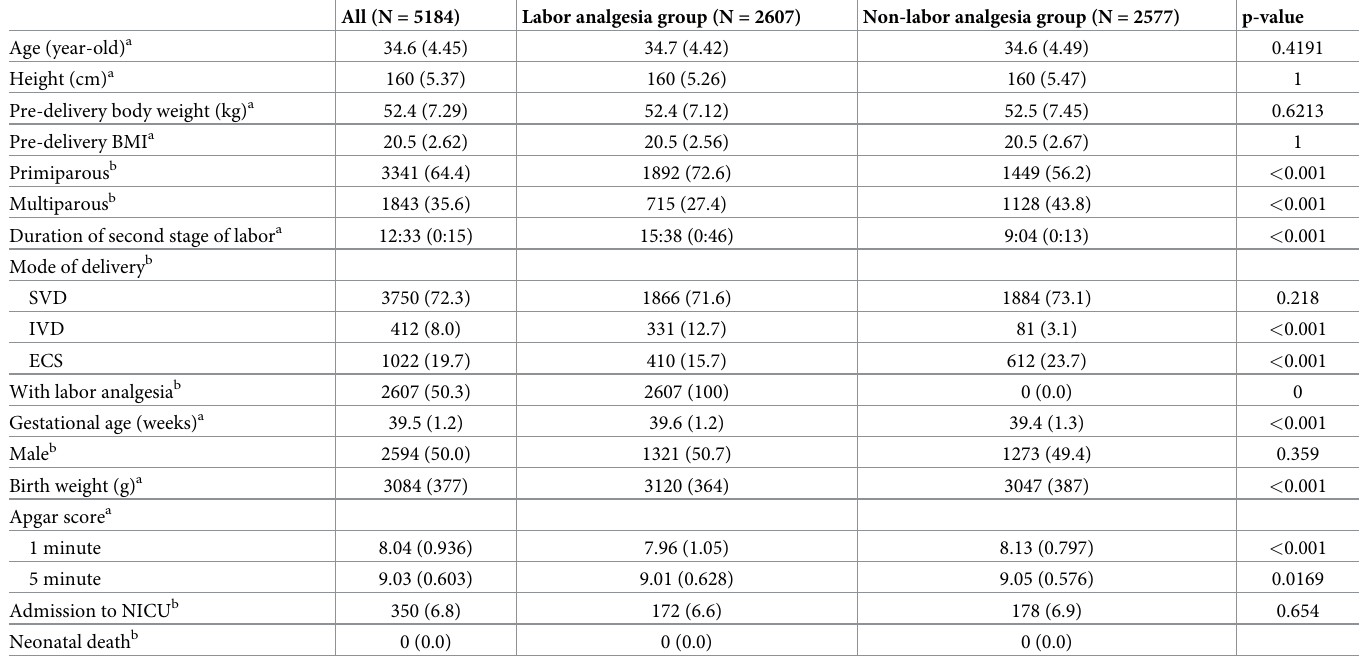
Table 1. Patients characteristics and association between labor analgesia group and Non-labor analgesia group at obstetrics inpatients. (N = 5184). All (N = 5184) Labor analgesia group (N =